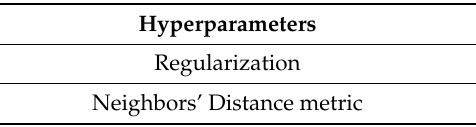
Figure 7. Experimental and modeled variogram models for Walkerlake data; from top left to bottom right in ( a ) 0, ( b ) 45, ( c ) 90 and ( d ) 135 degrees Azimuth including ( e ) an omnidirectional and ( f ) variograms in all directions. Table 5. Optimum Hyper-Parameters MLR.